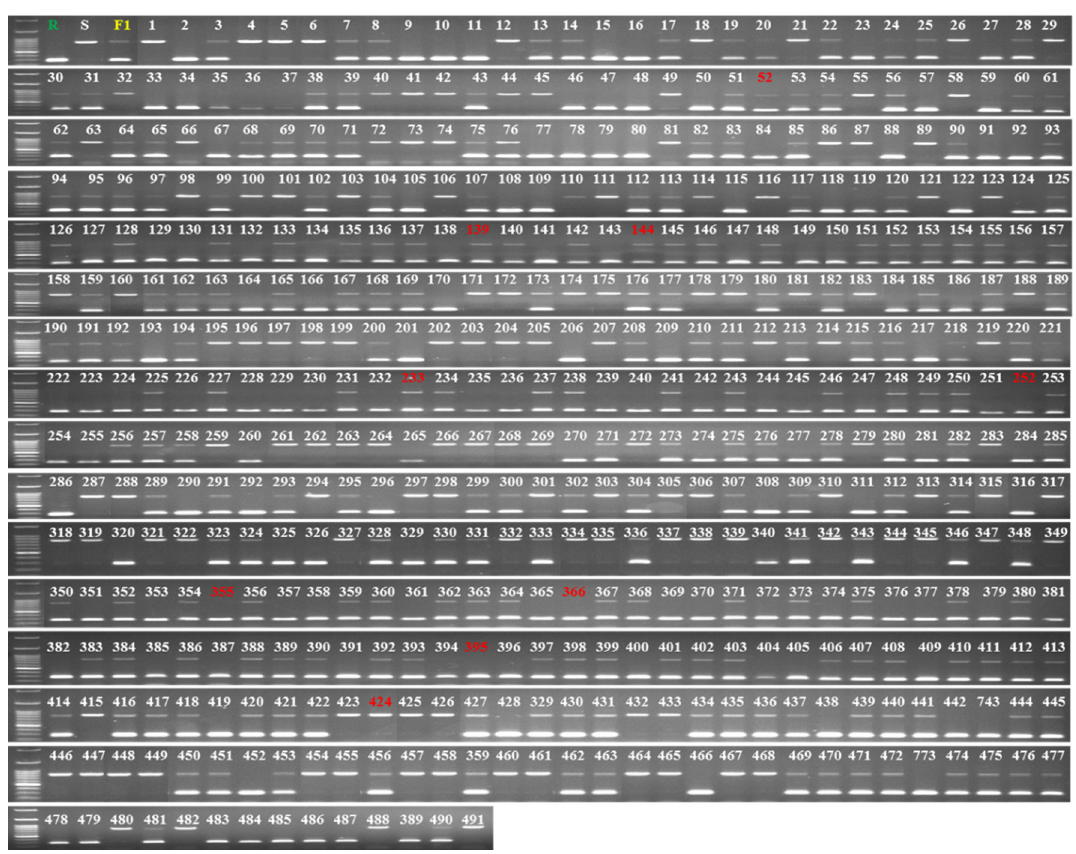
Figure 6. Validation of the InDel marker MB175-2 in 491 plants of an F 2 population raised from resistant and susceptible parental accessions PI 353814 and PI 614596, respectively. Red numbers indicate accessions with a mismatch between phenotypic and genotypic results.